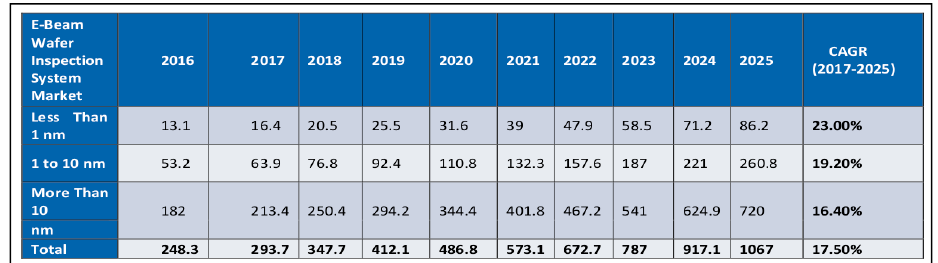
Figure 31. Global e-beam wafer inspection system market size (USD Mn) forecast by type, 2016–2025.